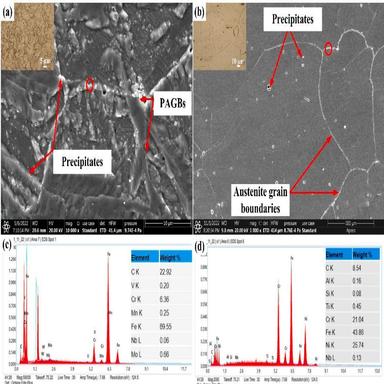
Micrographs and EDS spectrum of base metals: (a) P91 microstructure; (b) IN 800HT microstructure; (c) elemental composition of circled P91 precipitates; (d) elemental composition of circled IN 800HT precipitates.